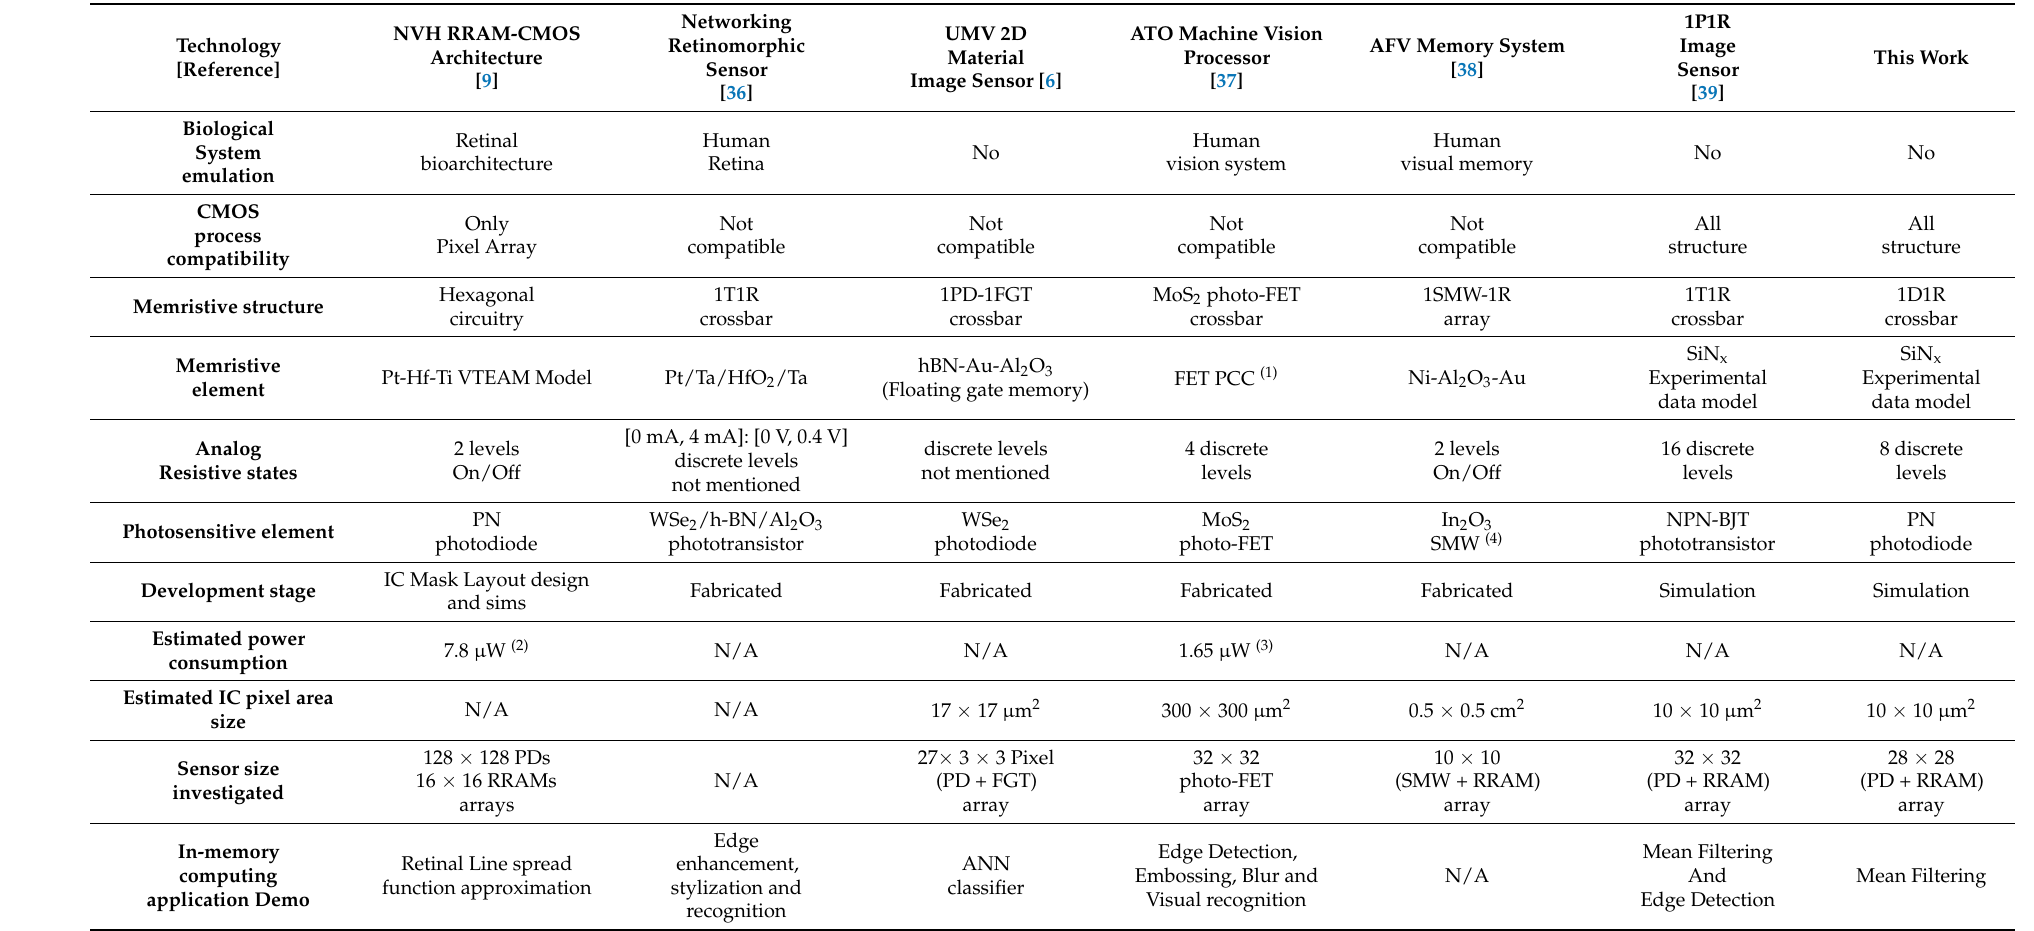
Table 2. In-sensor computing concepts based on RRAM